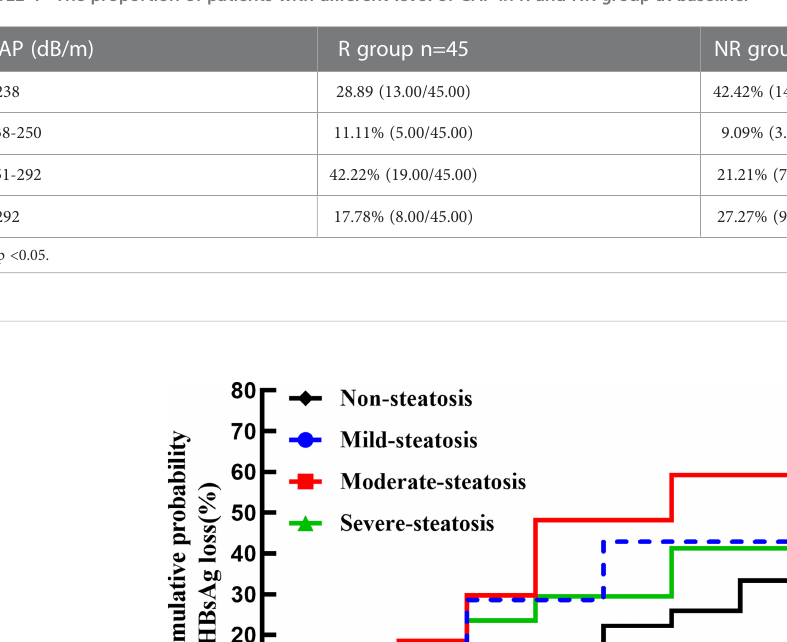
TABLE 4 The proportion of patients with different level of CAP in R and NR group at baseline.